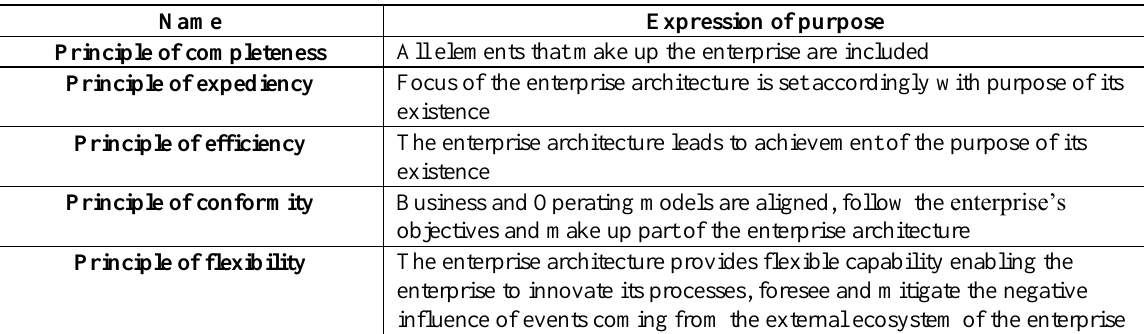
Table 2 . Principles impacting proposed